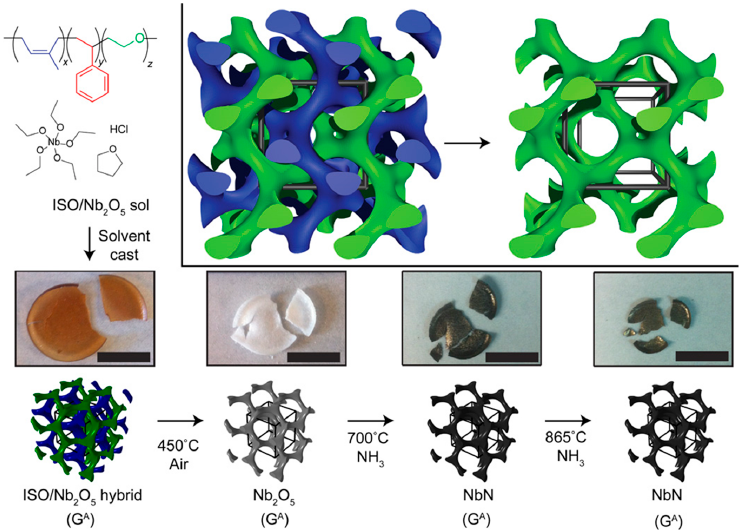
Figure 9. Gyroid-forming PI- b -PS- b -PEO block copolymers and the preparation process of NbN superconductors. Reprinted with permission from Reference [75]. (Copyright (2016) the authors).